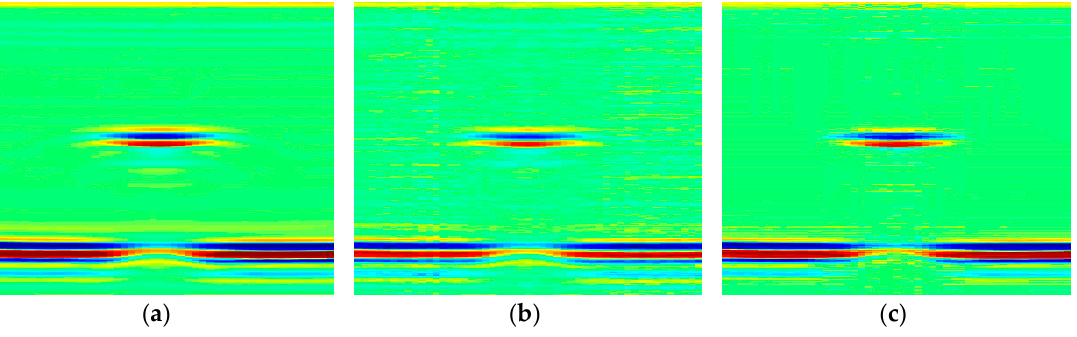
Figure 25. ( a ) The original 50 MHz SR experimental image of No. 3 pit; ( b ) the reconstructed image of ( a ) in time domain, CR = 60%, PSNR = 36.86 dB; ( c ) the recovery result in frequency domain, SR = 20 MHz, CR = 50%, PSNR = 40.84 dB.